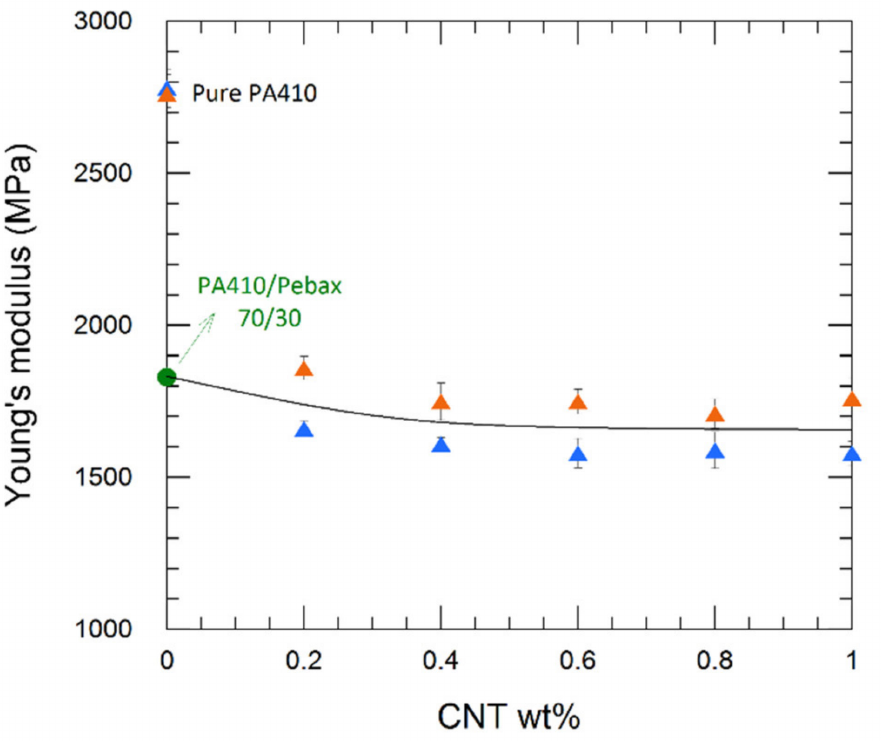
Figure 9. Young’s modulus of PA410/Pebax/CNT ( (cid:78) ) and PA410/PA6/Pebax/CNT ( (cid:78) ) NCs vs. the